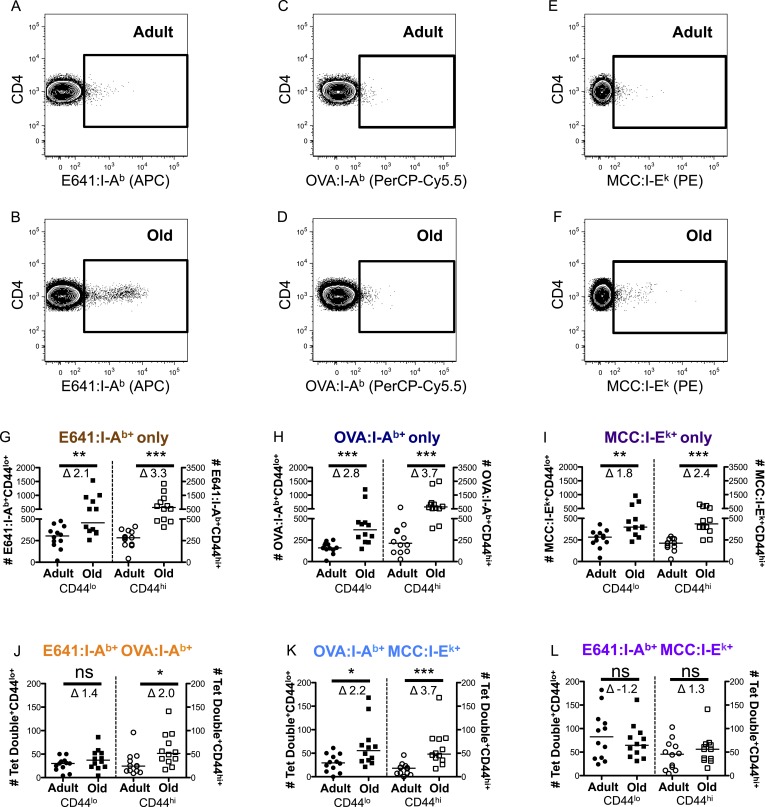
CD44lo and CD44hi CD4+ T-cells binding immunodominant, subdominant, and allogeneic pMHC increase with time.Representative plots of CD4+ T-cells bound to (A and B) E641:I-Ab, (C and D) OVA:I-Ab, and (E and F) MCC:I-Ek tetramers in adult (top) and old (bottom) mice. Absolute number of CD4+ CD44lo (left Y-axis) and CD4+ CD44hi (right Y-axis) T-cells bound to (G) E641:I-Ab, (H) OVA:I-Ab, or (I) MCC:I-Ek tetramers only enumerated after dump tetramer analysis (‘Materials and methods’), or those binding (J) E641:I-Ab + OVA:I-Ab, (K) OVA:I-Ab + MCC:I-Ek, or (L) E64:I-Ab + MCC:I-Ek tetramers in combination enumerated after both dump and two-color tetramer analysis (‘Materials and methods’). Bars indicate median (*p < 0.05, **p < 0.005, ***p < 0.0001, ns = non-significant; Mann–Whitney). Fold change (Δ) in means between adult and old is shown. Results are from three experiments with 4 mice/group.